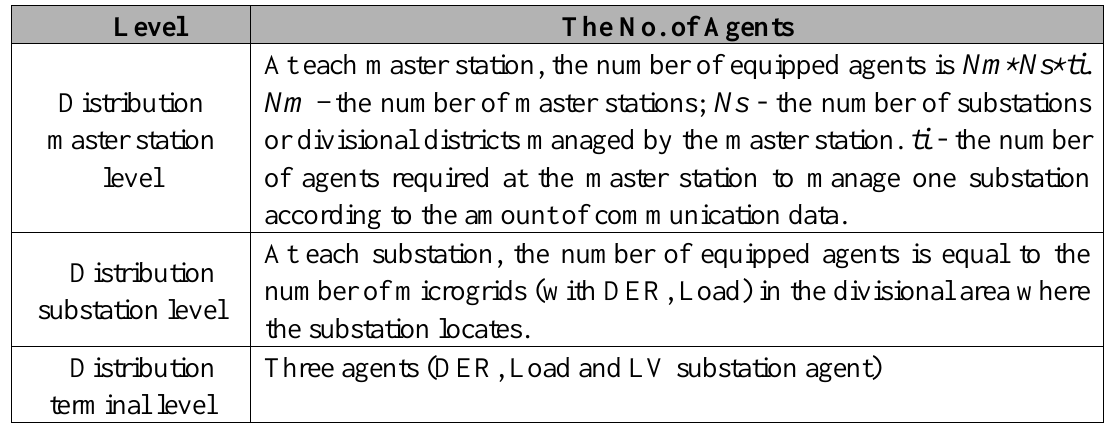
Table 1. Control levels of the